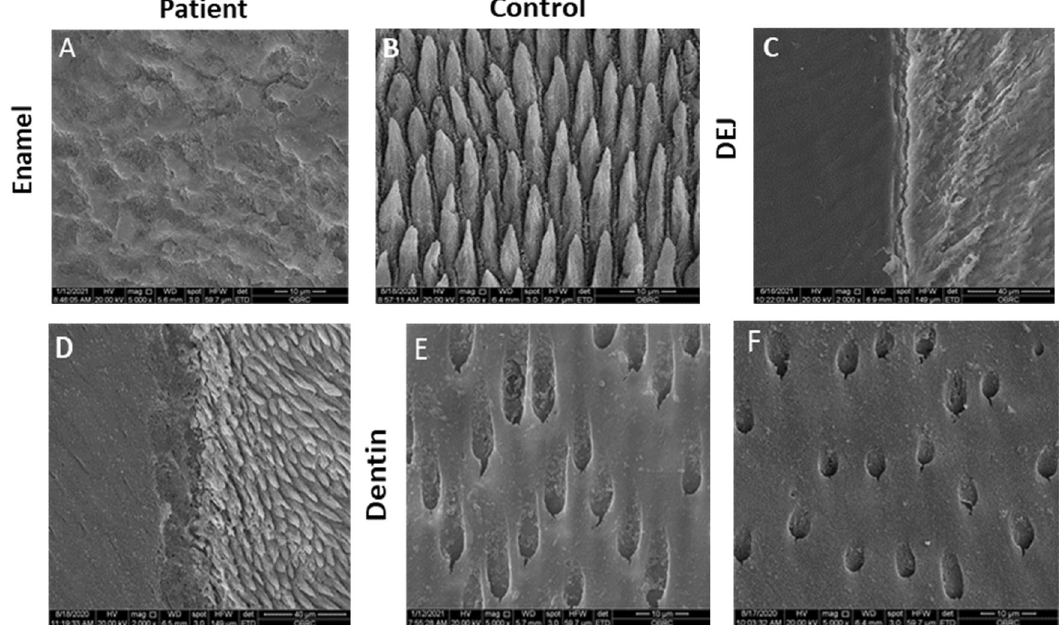
Fig. 4 Ultrastructure of ITGB6 tooth. A , B SEM showed disorganized, fl atted, and collapsed enamel rods in the patient ’ s tooth while an organized arrangement of enamel rods was observed in control. C , D A gap in the dentinoenamel junction of ITGB6 tooth was observed while control showed a smooth connection between enamel and dentin. E , F The dentinal ITGB6 was similar to that of the control